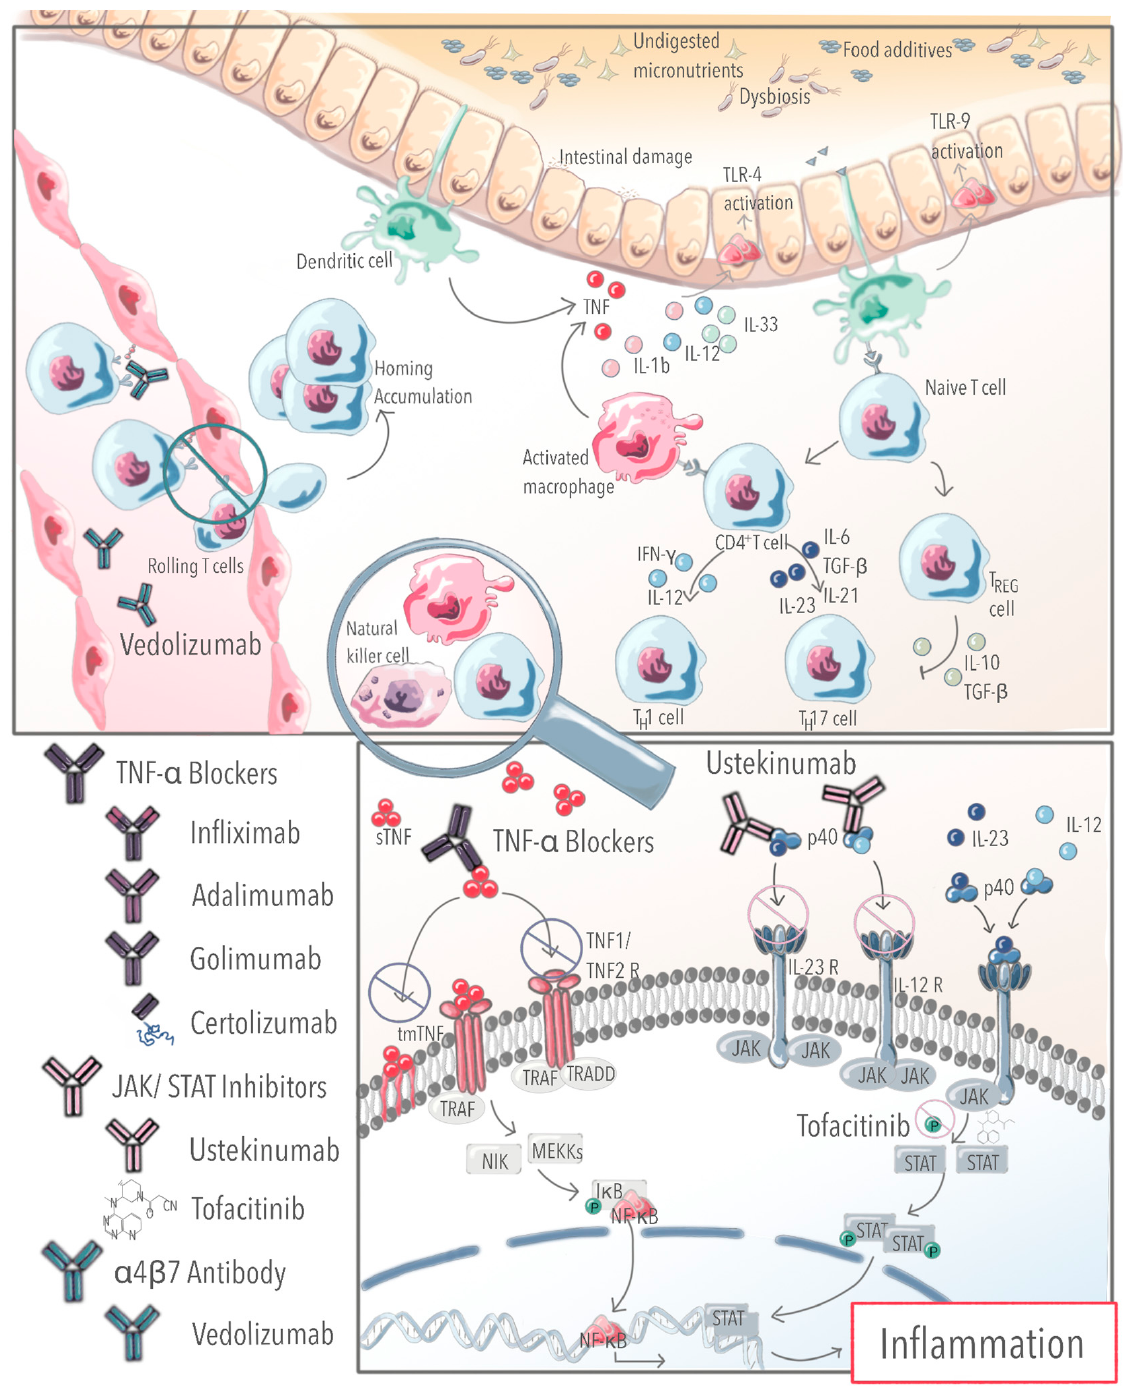
Figure 1. Overview of pathophysiological mechanisms and the effects of biologic agents currently used in pediatric IBD.